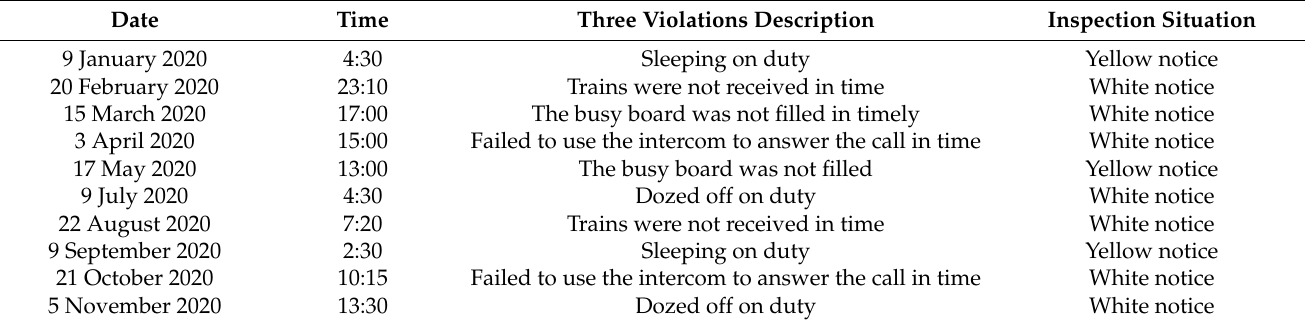
Table 14. Violation statistics of “the assistant watchman did not appear as